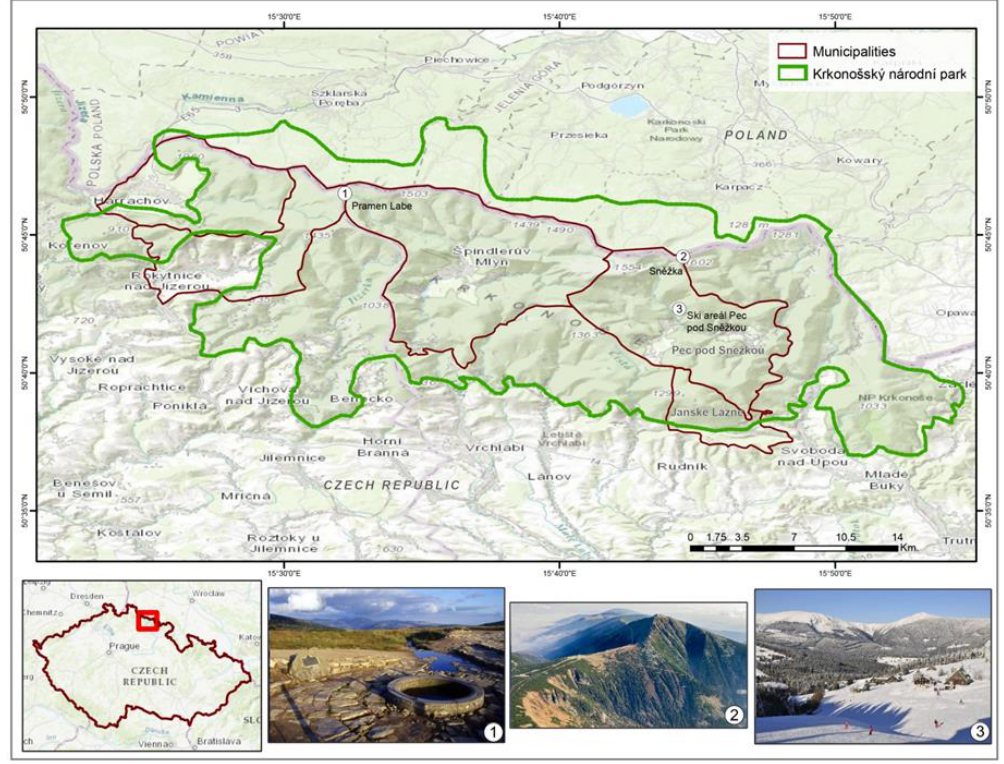
Fig. 1. Location of the study